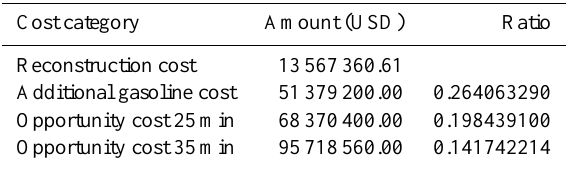
Table 3. Vehicle type and different gasoline prices in USD.